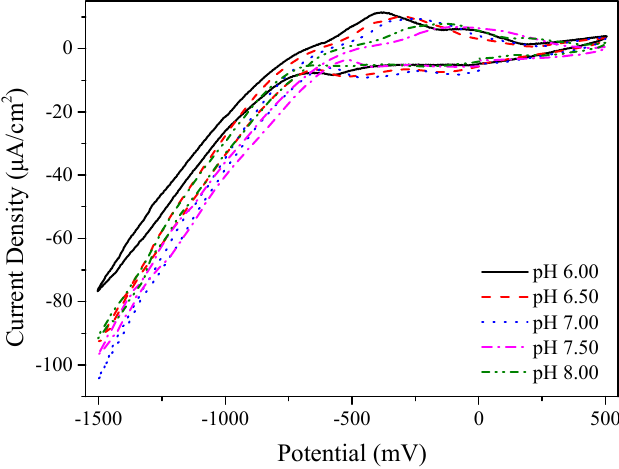
Figure 1. Cyclic voltammograms for the substrate in the Mn electrolyte with different pH values.